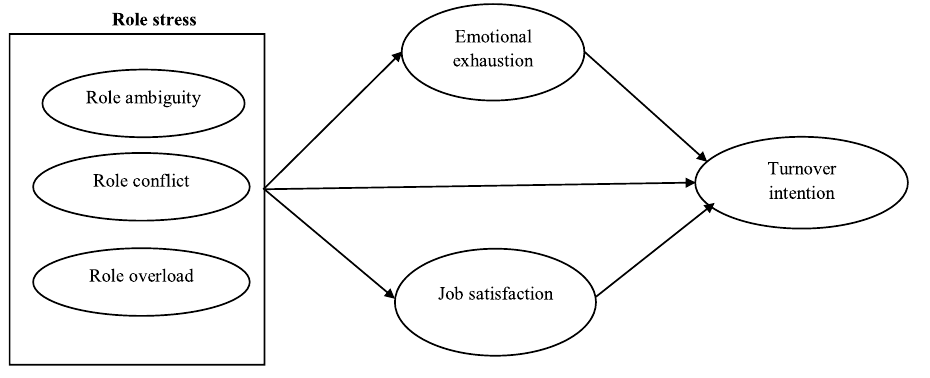
Figure 1. Conceptual framework of the